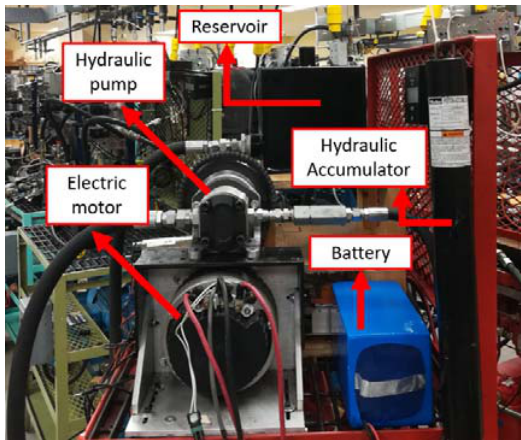
Figure 1. Hydraulic test bench.